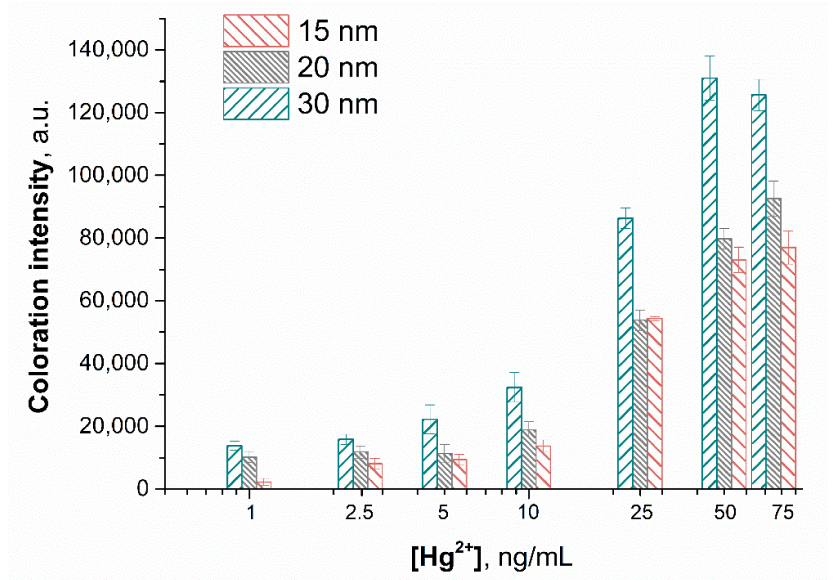
Figure 5. Effect of AuNPs size on the Hg 2+ detection by lateral flow test. Error bars show the standard deviations from three replicate measurements.